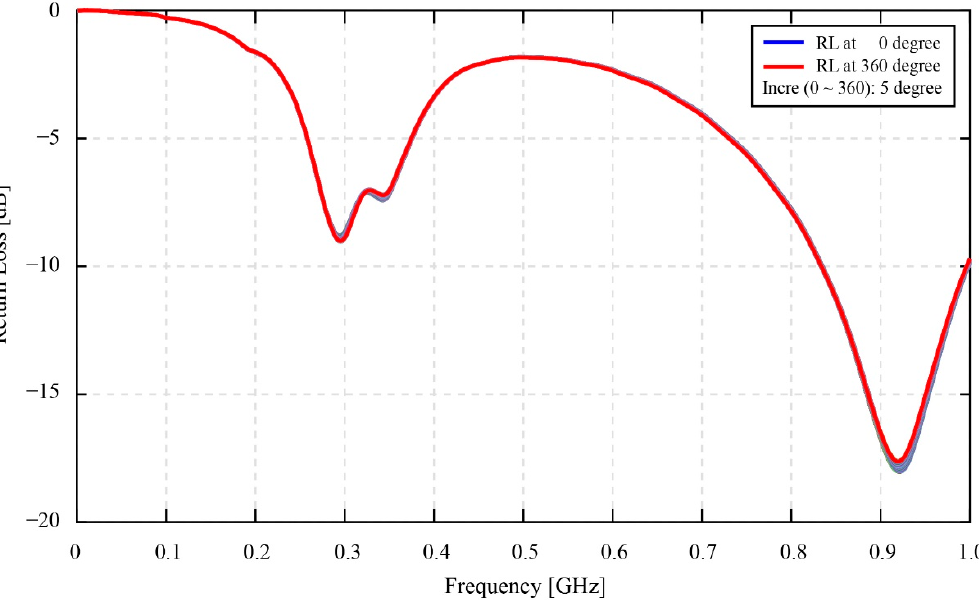
Figure 12. The effect of phase fluctuation on the resonant signals of the smart gear system in static conditions.